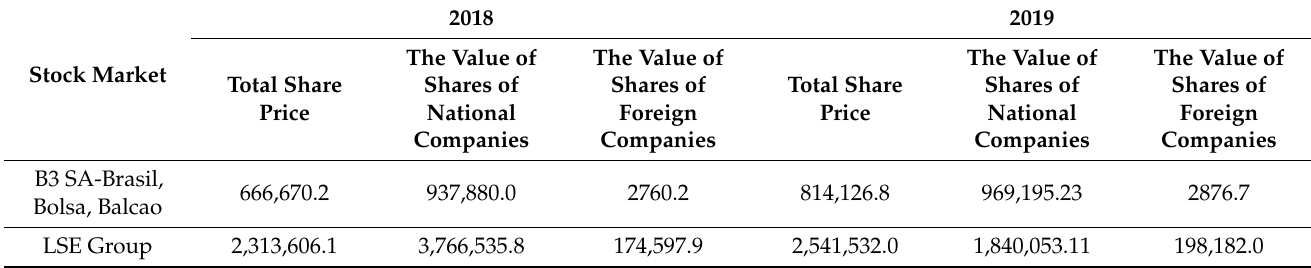
Table 1. The value of shares of national companies and foreign companies in 2018–2019.